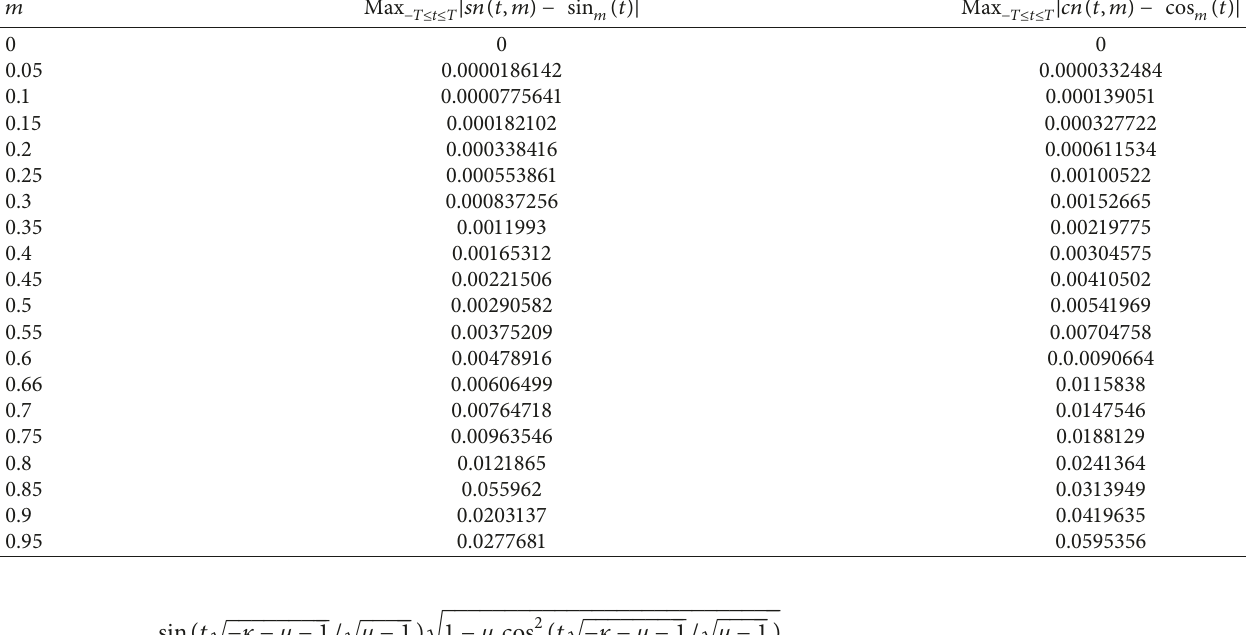
Table 1: Errors for approximations (46) and